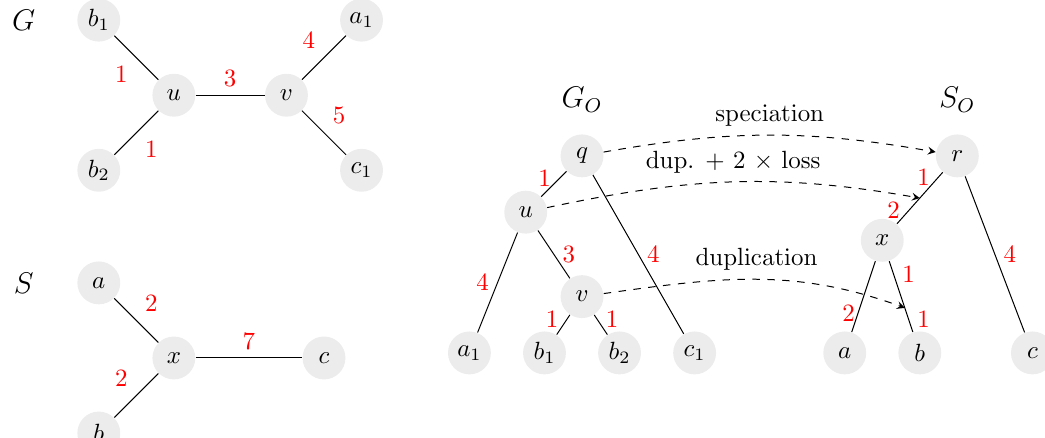
Figure 2. An example of an isometric reconciliation of two unrooted trees. On the left, the input gene tree G and species tree S are shown, both unrooted. On the right is one possible solution, consisting of rooted trees G O and S O and a mapping between them. The species tree is rooted on edge distance 4 from c . Once the root of S is fixed, the rest of the solution is given uniquely. All possible x , c roots in S are located on the edge in distances from 0 to 5 from c . Note that in our algorithm, { } we preprocess tree S to have two leaves b 1 and b 2 instead of leaf b , so that the leaves of G and S are in one-to-one correspondence (see Sections 2.1 and